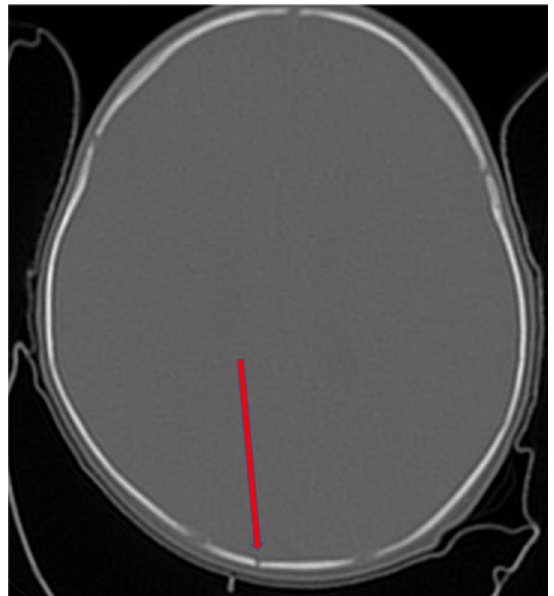
Fig. 1 Error in radiology diagnosis: normal median Occipital fissure misdiagnosed as fracture of occipital bone